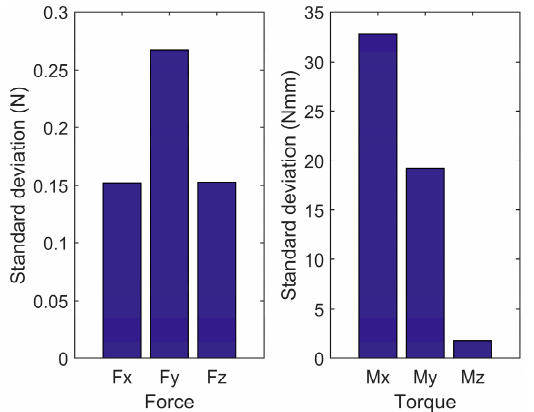
Figure 23. Forces and torques deviation of human beings.